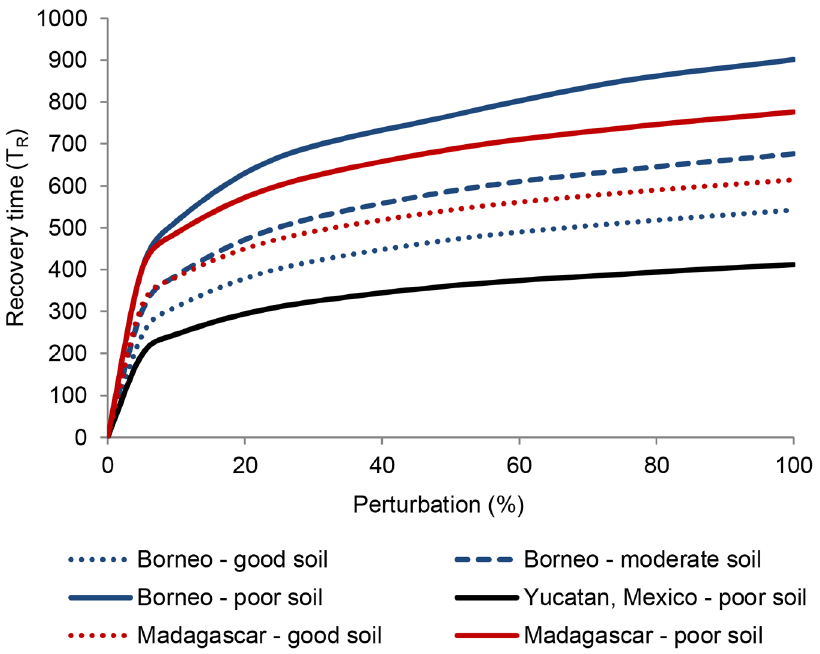
Fig 9. Recovery time of a fully mature forest as a function of the extent of perturbation. The fully mature forest state means that all patches are in the f 5 stage, which, by definition, means there is no agricultural